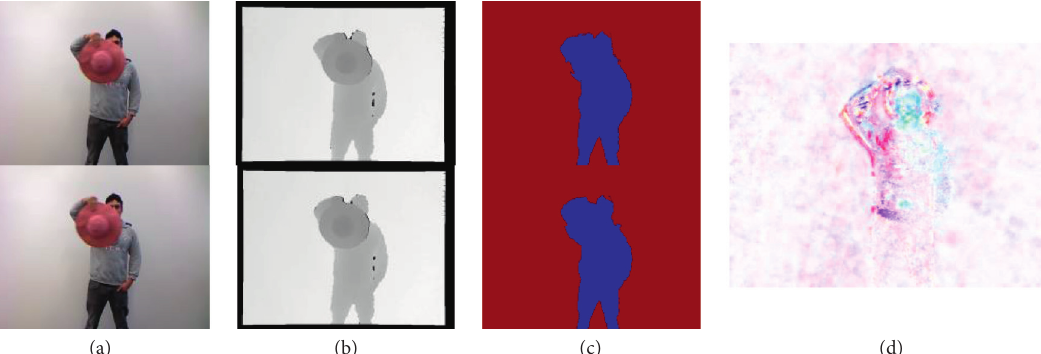
Figure 3: “Hat” sequence [26] without spatial constraints of scene flow. Two consecutive frames from “Hat” sequence are input and segmented into 2 regions to estimate scene flow. (a) RGB images. (b) Depth images. (c) Segmentation K � 2. (d) Scene flow.